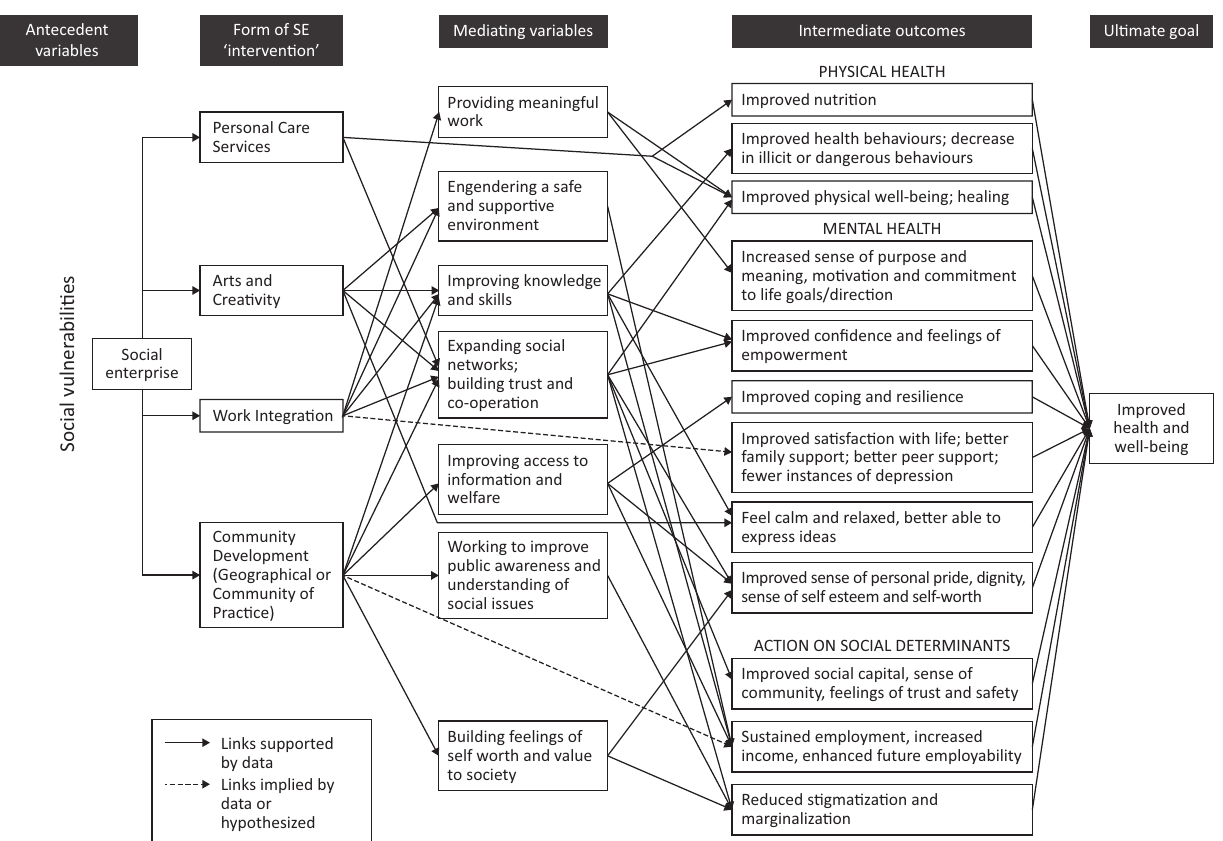
Figure 1. Conceptual model of social enterprise as a health and well-being intervention (Roy et al., 2017). neighbourhood (Wagemakers, Mulderij,